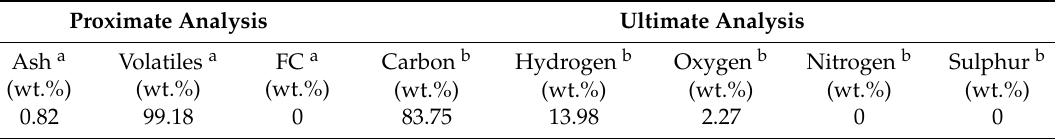
Table 1. Composition of representative waste plastic employed in the present study [30]. Proximate Analysis Ultimate Analysis